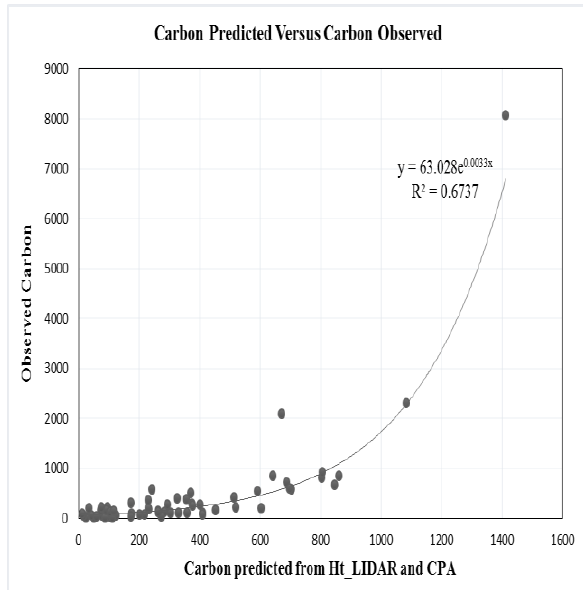
Figure 8. Scatter plot of multiple regression model validation